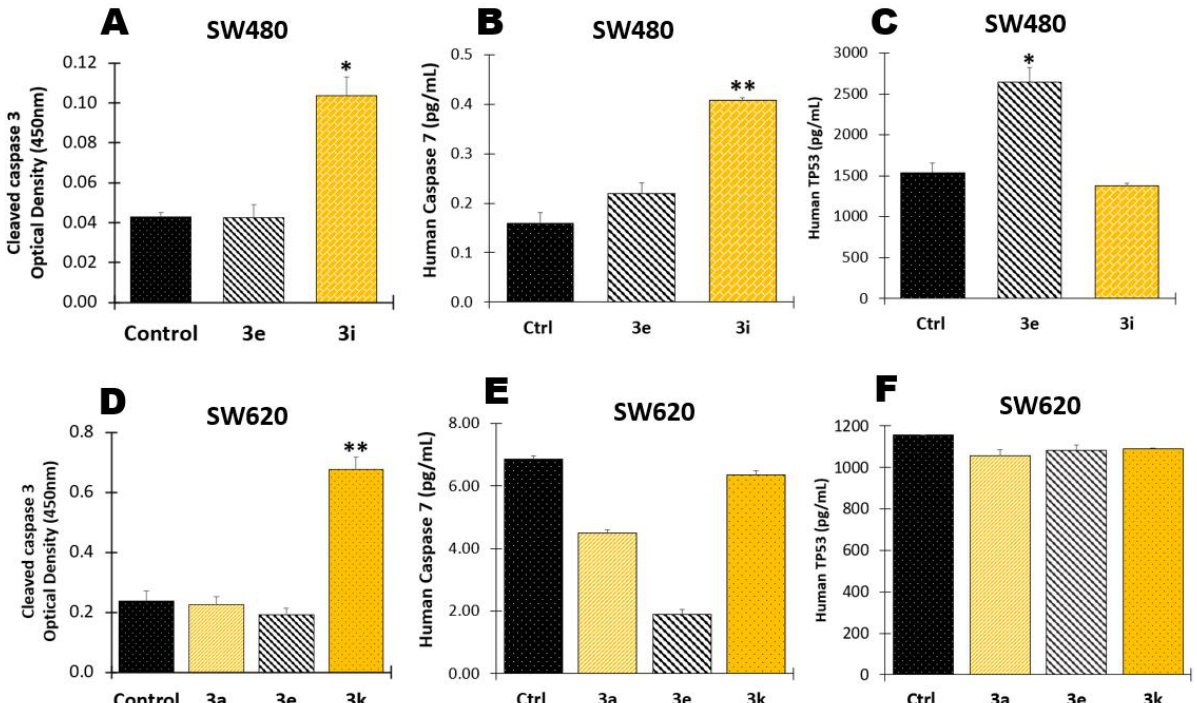
Figure 7. Determination of apoptotic biomarkers in SW480 ( A – C ) and SW620 ( D – F ) cells. Cells were harvested 48 h after treatment with hybrids 3a – 3d or the vehicle control (DMSO 1%). Protein levels of cleaved caspase3 ( A , D ), human caspase 7 ( B , E ) and human TP53 ( C , F ). Data are presented as the mean ± SE of two independent experiments. (* p < 0.05; ** p < 0.01). Optical density is directly proportional to the concentration of protein.